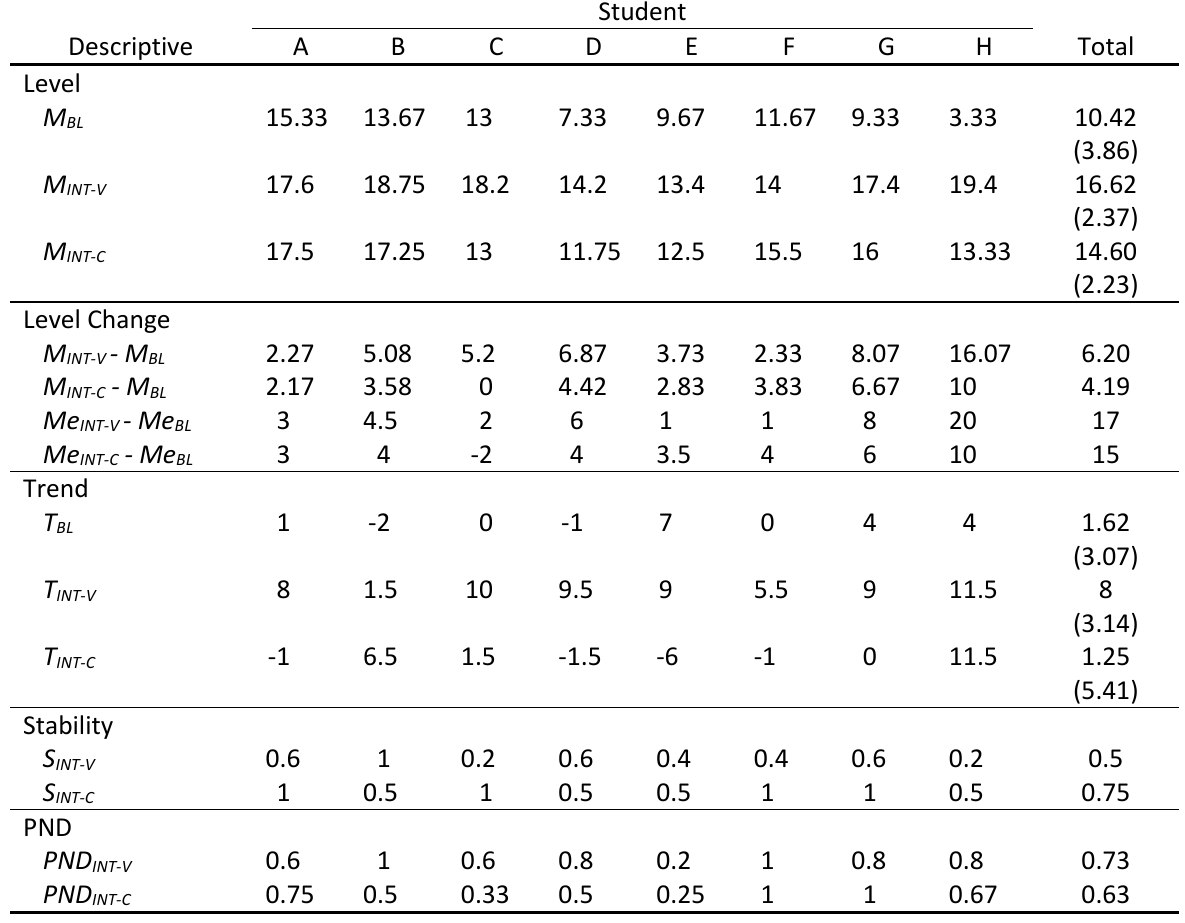
Table 3: Visual Analysis and Effect Size Calculation